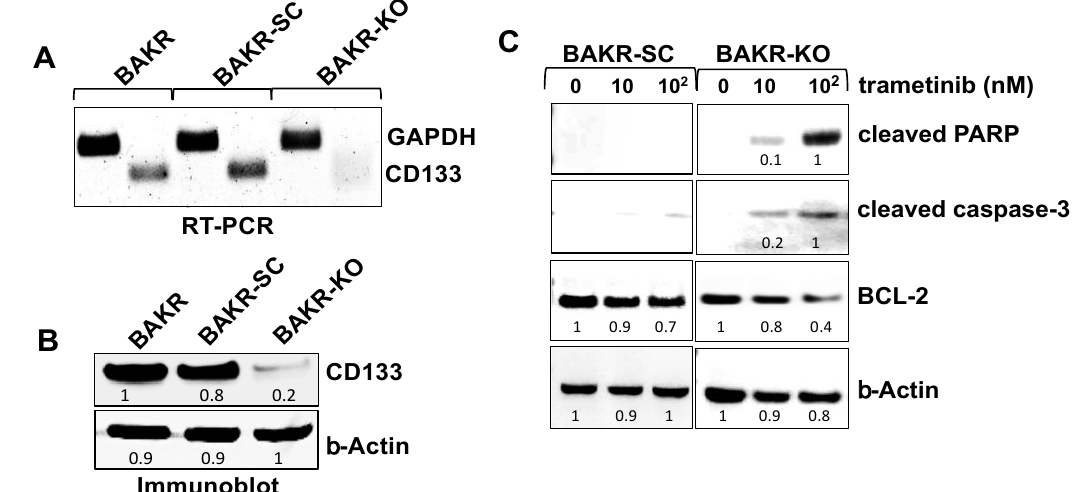
Figure 2. CRISPR-Cas9 CD133-knockout sensitizes BAKR-KO cells to trametinib-induced apoptosis via reduced BCL-2 levels. CD133 expression was compared between BAKR, CD133-knockout BAKR-KO, and sgRNA control BAKR-SC cells. ( A ) RT-PCR and ( B ) immunoblot analysis confirm depletion of CD133 RNA and protein, respectively, in BAKR-KO, compared to BAKR-SC and BAKR cells. ( C ) BAKR-SC and BAKR-KO cells were exposed to increasing trametinib concentrations for 72 h and subjected to immunoblot analysis with antibodies to the active cleaved form of caspase-3 (p17). Immunoblots were stripped of antibodies and re-probed with antibodies to cleaved PARP, BCL-2, and β -Actin for loading control. Densitometric analysis comparing intensities of protein bands relative to bands with the highest intensity is shown in immunoblots.